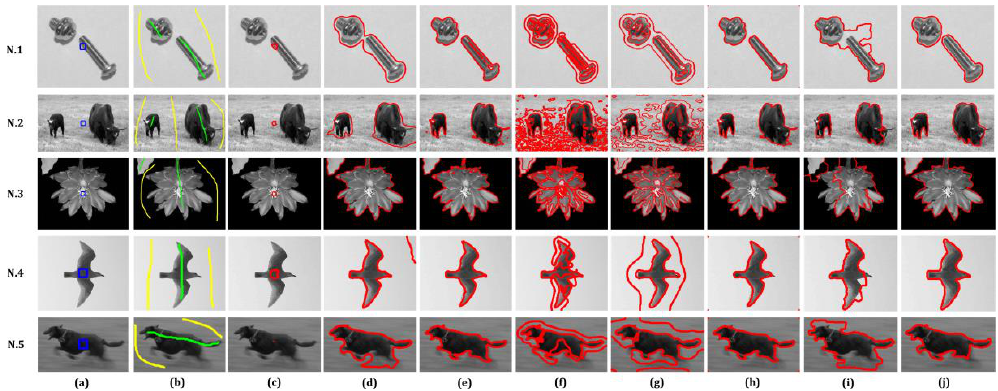
Figure 8 . Segmentation results of natural image database: ( a ) initial contour of level set methods; ( b ) initial makers of MSRM; ( c ) GAC; ( d ) CV; ( e ) SBGFRLS; ( f ) LBF; ( g ) ILFE; ( h ) Cao’s model; ( i ) MSRM; ( j ) the proposed method.